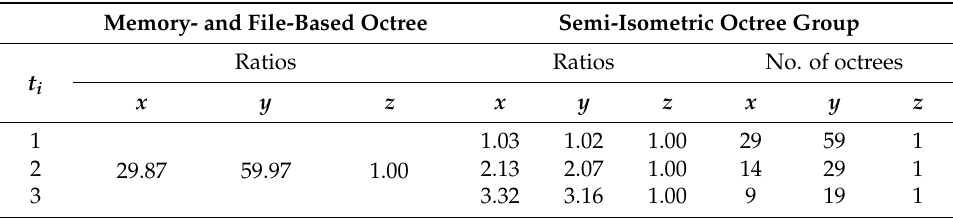
Table 3. Comparison of leaf node dimensions of Data 1.